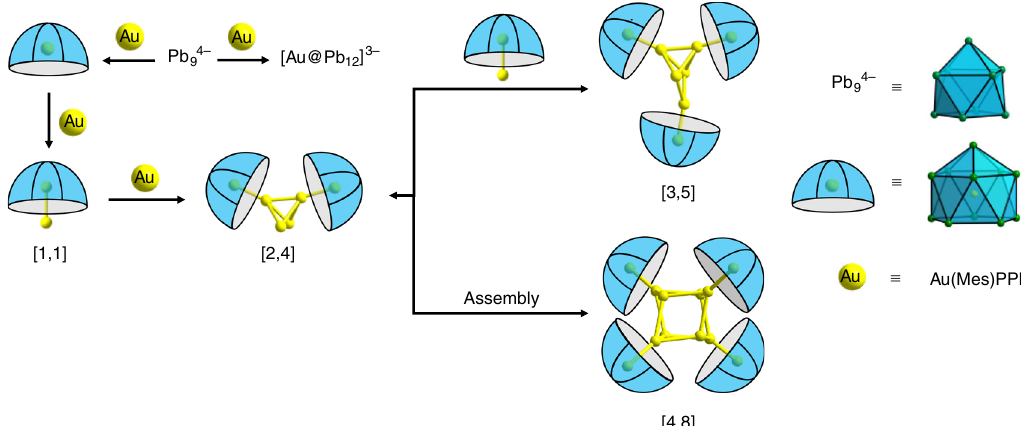
Fig. 5 Possible pathways leading to cluster growth. Coalescence of smaller component clusters leads to the assembly of [Au 8 Pb 33 ] 6 − ([3, 5]) and [Au 12 Pb 44 ] 8 − ([4, 8]). The [1, 1], [3, 5] and [4, 8] clusters have been observed, either by X-ray crystallography